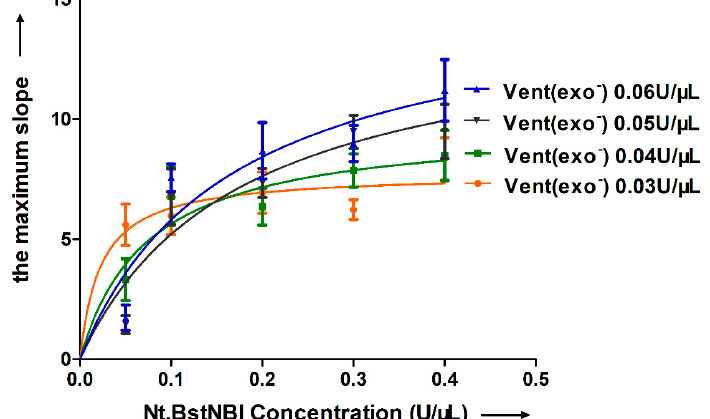
Figure 3. Effect of fluorescent dyes and template quantity on EXPAR. ( A – B ) 1 μ L of 20× SYBR Green I was adopted as the optimal amount for the subsequent EXPAR; ( C – D ) 0.1 μ M template was used as the optimum template concentration in 20 μ L reaction volume.